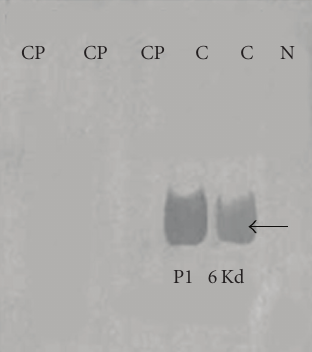
Figure 5: Western blots of protamine 1 in epididymal sperm of sexually mature rats depicting the presence of 6Kd protamine 1 bands in control and absence in drug-treated rats. Cp: Cyproterone acetate; C: Control; N: negative control. Basic proteins were extracted in HCl, di ff erentially extracted in trichloroacetic acid, analysed on 15% acid urea PAGE. Western blotting was done with 1Hup 1N monoclonal antibody provided by Dr. Rod Balhorn